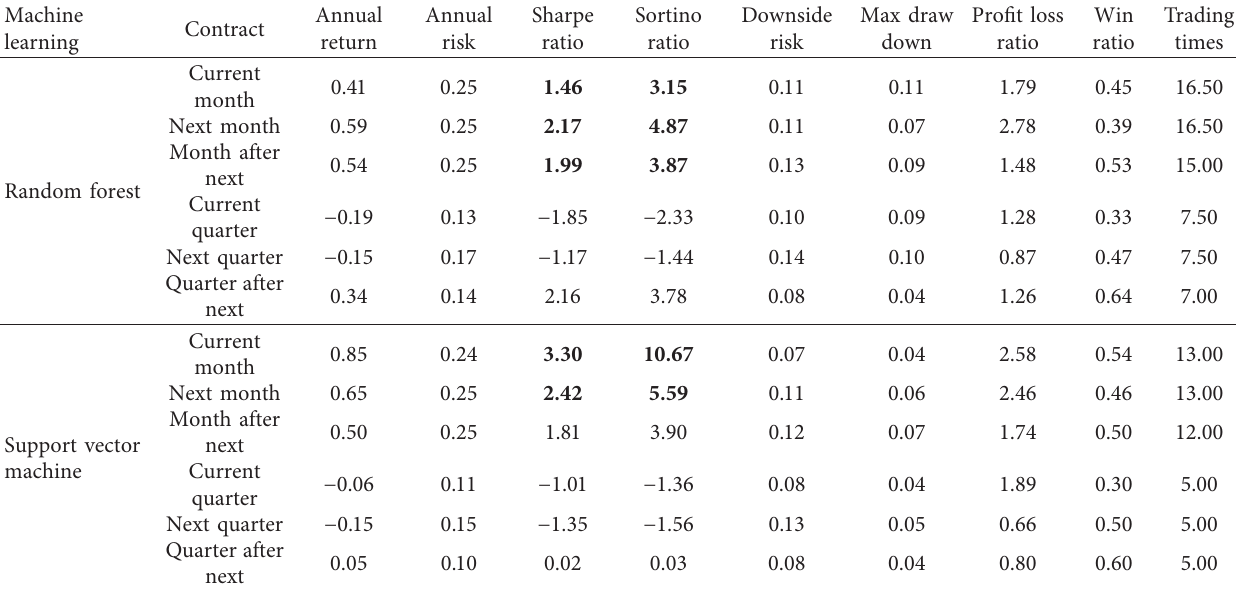
Table 19: Investment evaluation on train data set with parameters [0.05, −